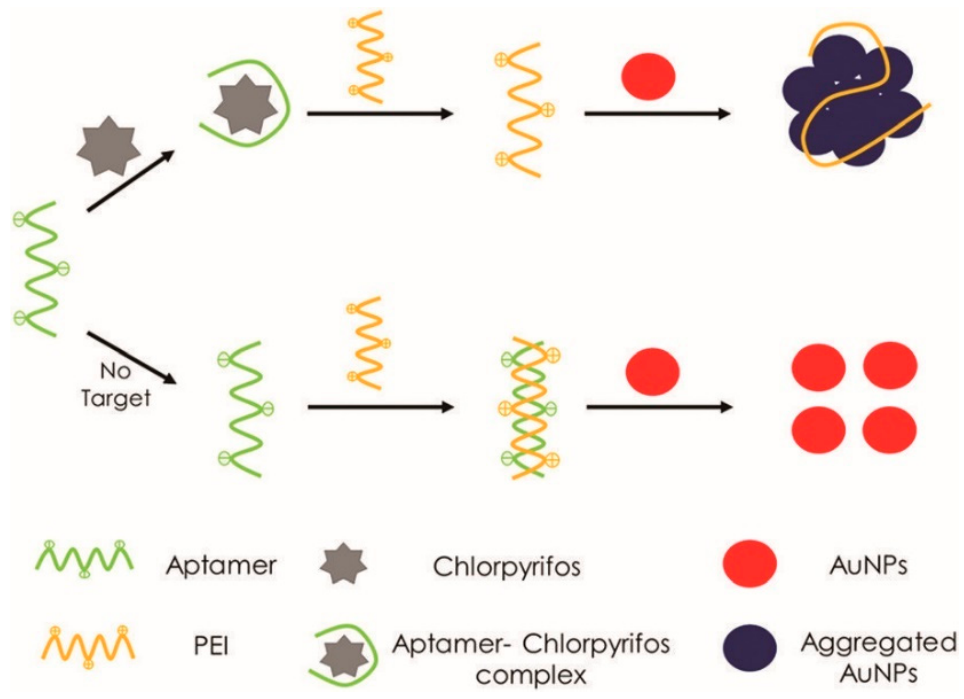
Figure 12. Colorimetric aptasensor for chlorpyrifos detection in water, pomelo and longan. Chlorpyrifos-specific aptamers prevent the aggregation of colloidal AuNPs by sequestering the ag- gregating agent polyethyleneimine. Upon detection of chlorpyrifos, the aptamer-polyethyleneimine are broken and the free polyethyleneimine molecules adsorb onto the metal surface leading to ag- gregation and a color change from red to blue. Image adapted from [92] with permission of Royal Society of Chemistry, 2021.